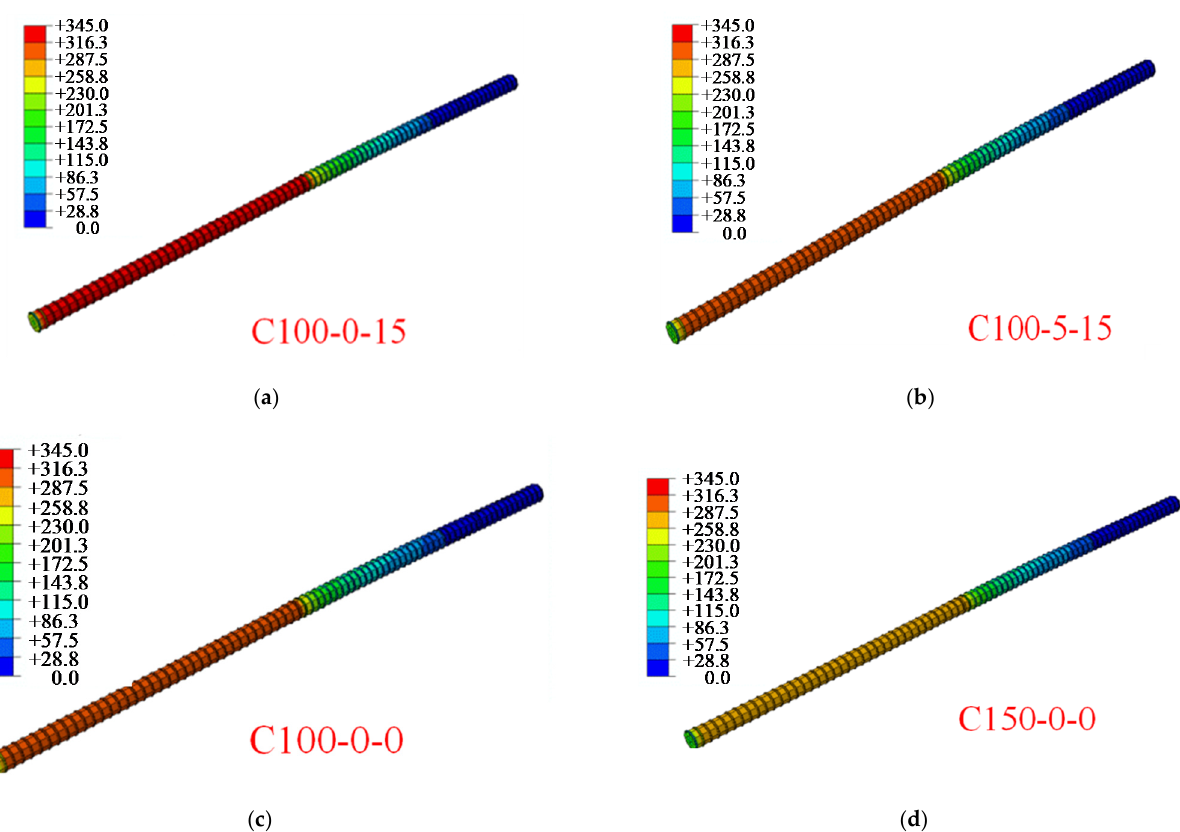
Figure 17. Von Mises stress distribution in reinforcement simulated by finite element method (MPa): ( a ) C100-0-15; ( b ) C100-5-15; ( c ) C100-0-0; ( d ) C150-0-0.